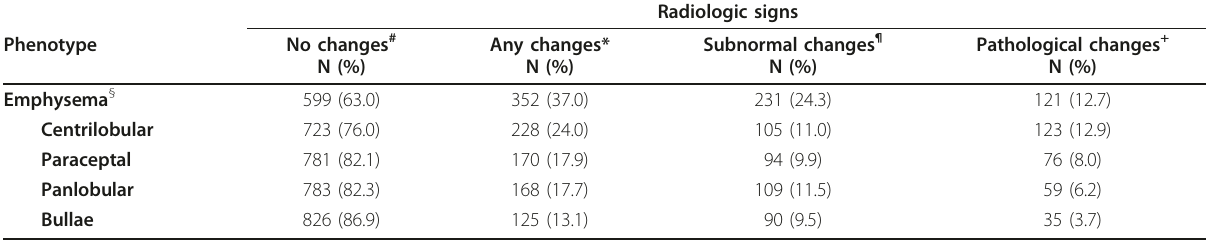
Table 3 Distribution of radiologic signs in relation to emphysema subtypes